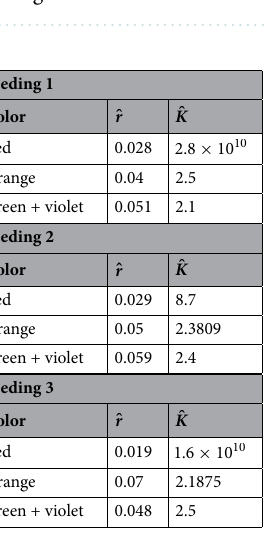
Figure 3. Time series solution of the proposed model and logistic law with comparative RSS for all three seeding conditions.